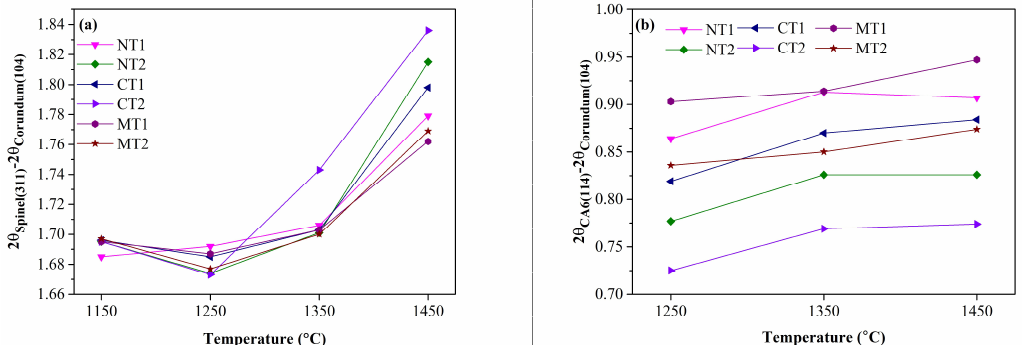
Figure 2. The shift of diffraction angle of spinel and CA 6 in samples calcined at different tempera- tures: ( a ) spinel and ( b ) CA 6. ( a ) spinel and ( b ) CA 6